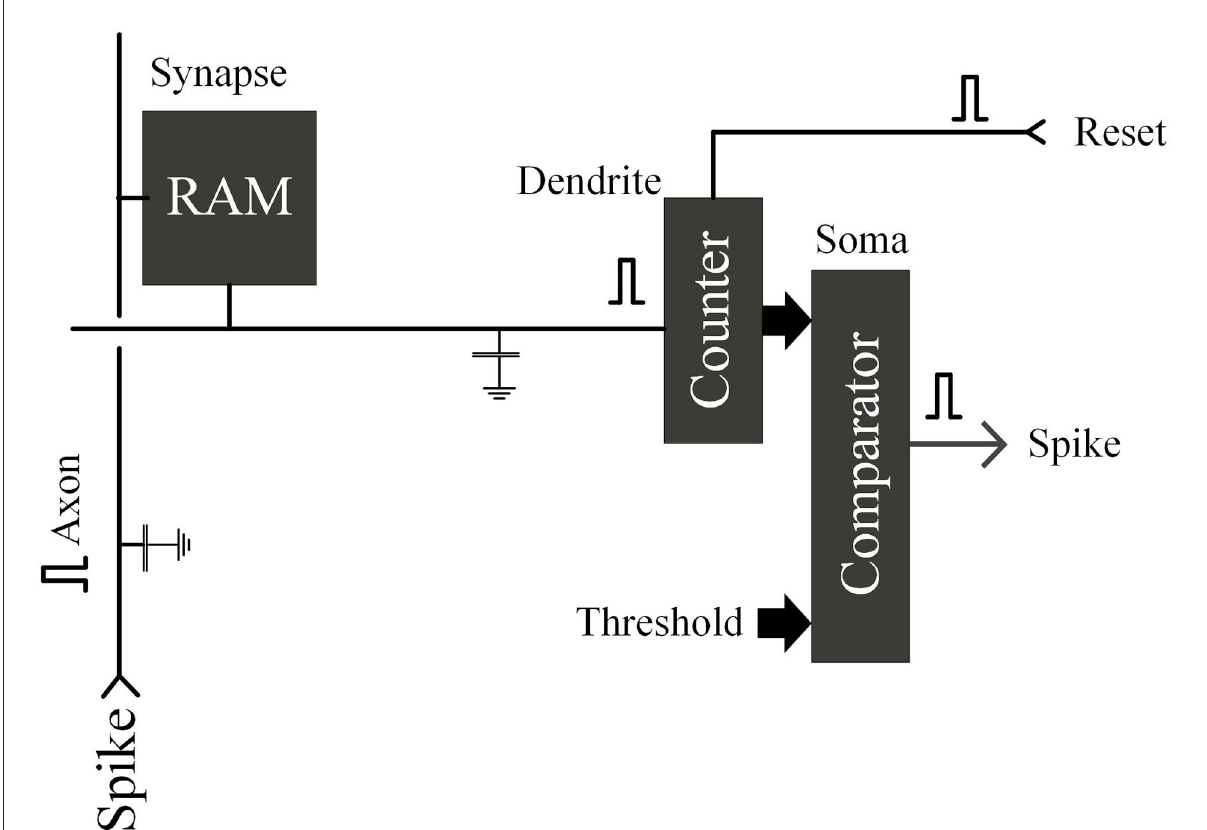
FIGURE10 Schematic diagram of analog neuron with cycle counting